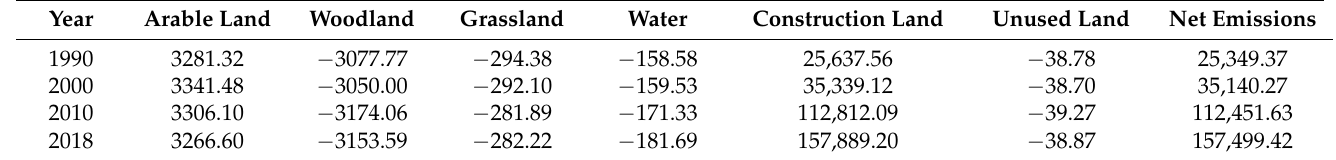
Table 3. Carbon emissions by land use types in the study area (10 4 t).